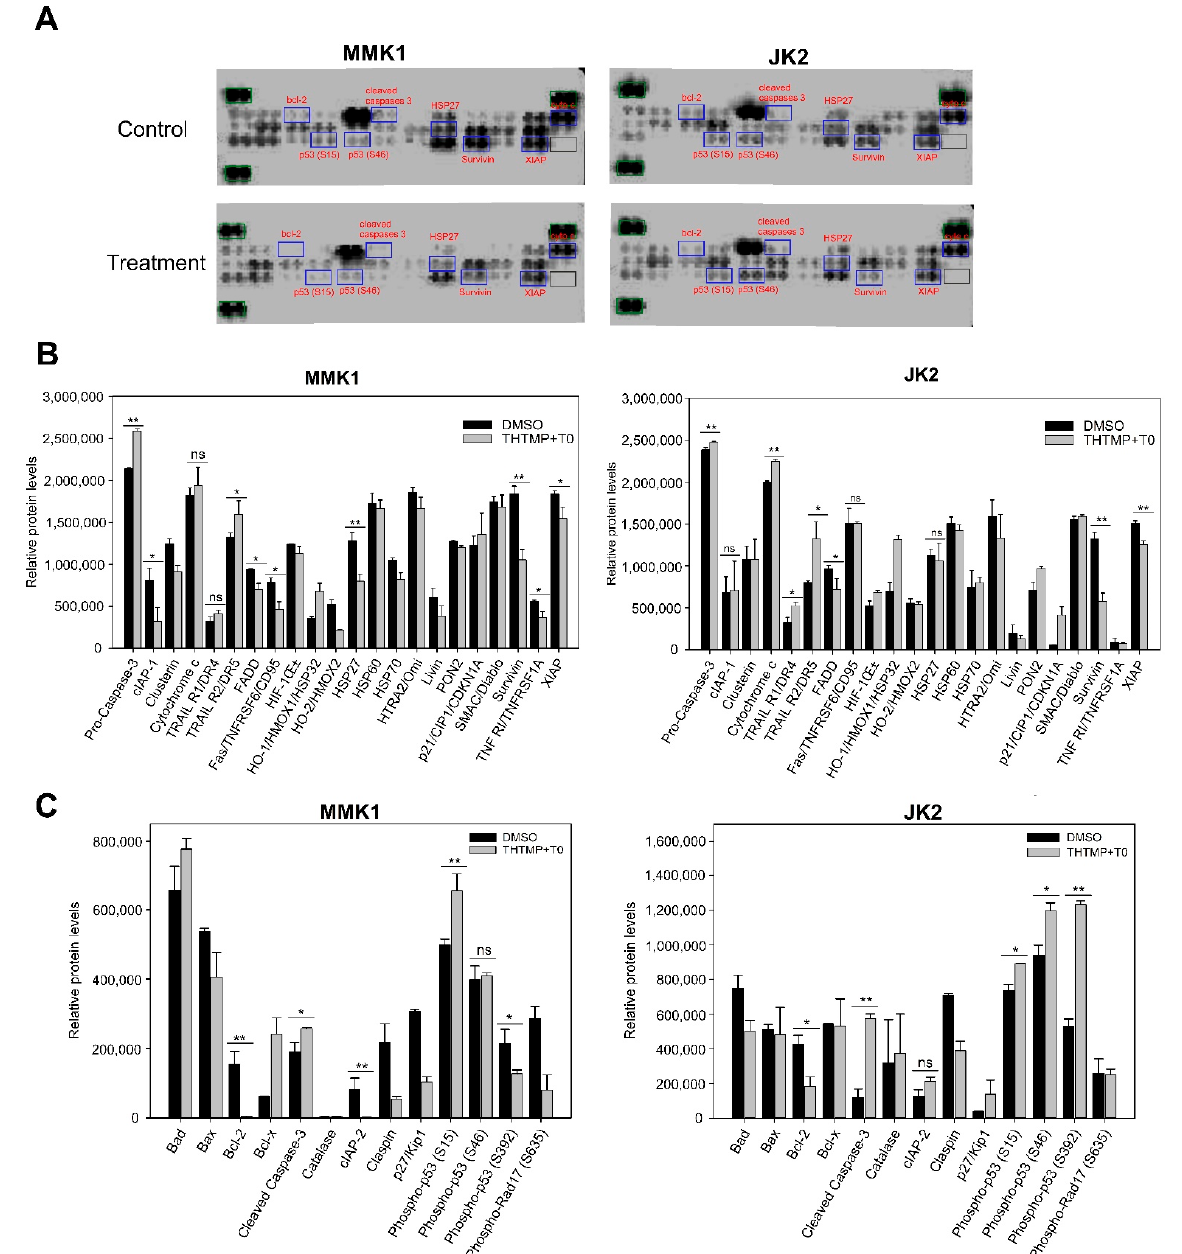
Figure 7. Proteome profiling of apoptosis-associated proteins. ( A ) Array images showing the expression of total 35 apoptosis-associated proteins upon combinatorial treatment with DMSO as control. ( B ) Relative level of expression of total 22 apoptotic proteins in the cell lysate of control and combinatorial treatment of MMK1 and JK2 cells ( C ) Integrated pixel intensity of 13 apoptotic proteins. The data were shown as mean ± SD; ns: not significant * indicates p < 0.05, ** p < 0.01.